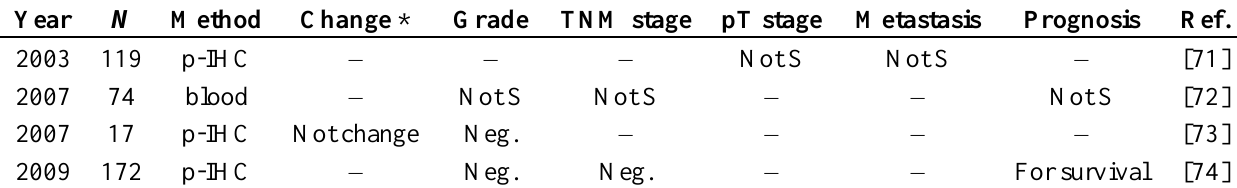
Table 2. Correlation between TSP-1 expression and clinicopathological features in renal cell carcinoma.